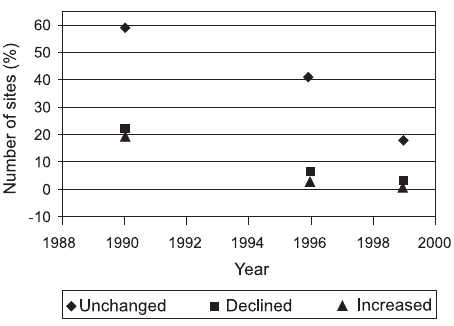
Fig. 6. Trend of sites with consistently unchanged, and progressively declined or increased vegetation structural